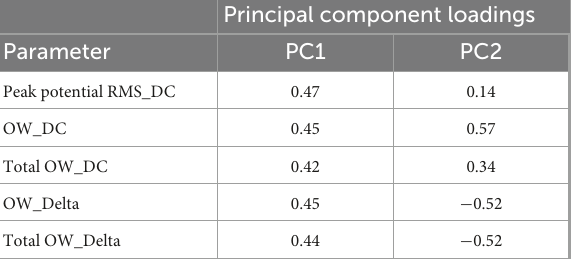
TABLE 4 Principal component loadings for PCA using effective parameter set for detecting the drug responses in human iPSC-derived astrocytes.